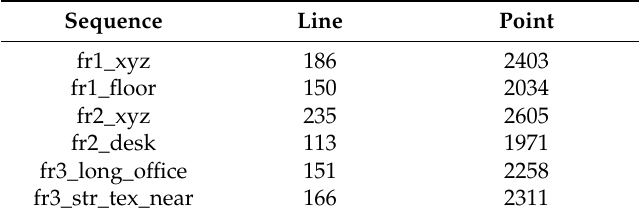
Table 2. The numbers of lines and points in maps created by LAP-SLAM.